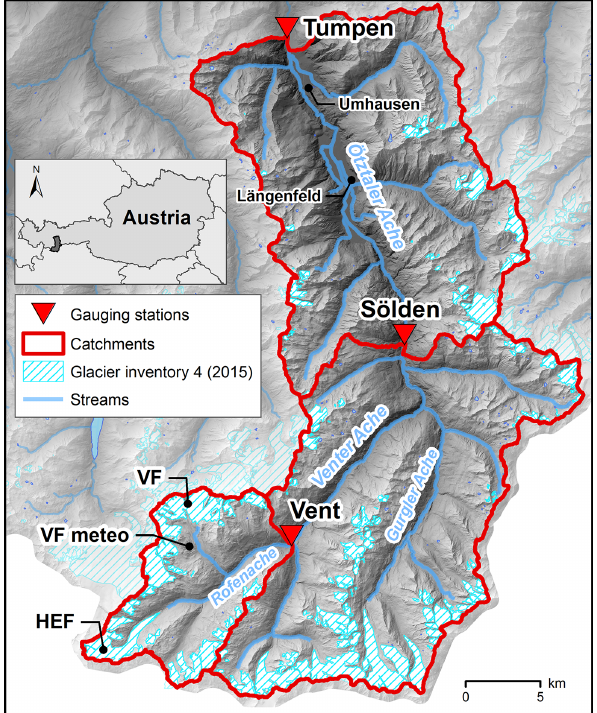
Figure 1. Nested catchment areas of the three gauging stations Vent, Sölden and Tumpen within the Upper Ötztal, Tyrol, Austria. The locations of the Hintereisferner and Vernagtferner glaciers are marked by HEF and VF, respectively. “VF meteo” shows the loca- tion of the Vernagtferner meteorological station (Bavarian Academy of Sciences and Humanities), providing precipitation and air tem- perature data for the event analysis. Sources: 10m DTM of Tyrol (Land Tirol, 2016), glacier inventory 4, 2015 (Buckel and Otto, 2018), rivers and water bodies from tiris open government data (Land Tirol,